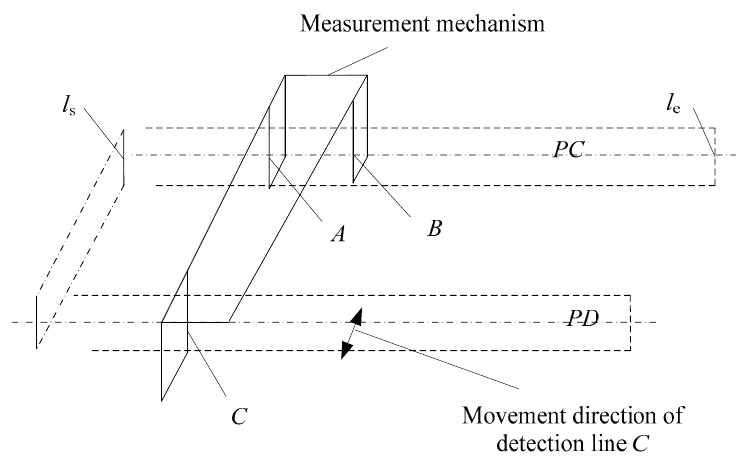
Figure 9. Detection model of two vertical parallel surfaces.